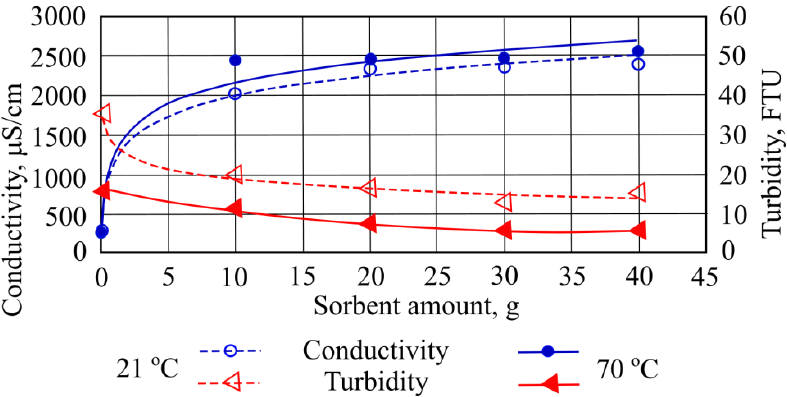
Figure 10. Electrical conductivity and turbidity using different quantities of mineral granulated sorbent.